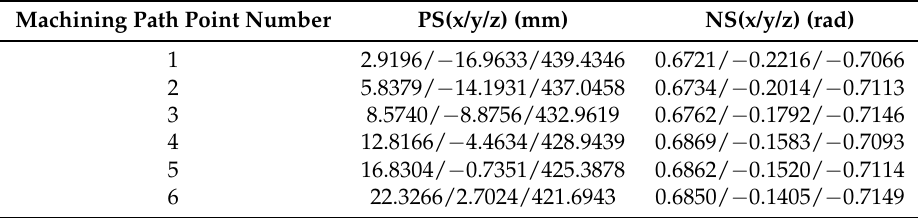
Table 3. Machining path points in the scanner frame detected by the 3D vision system.